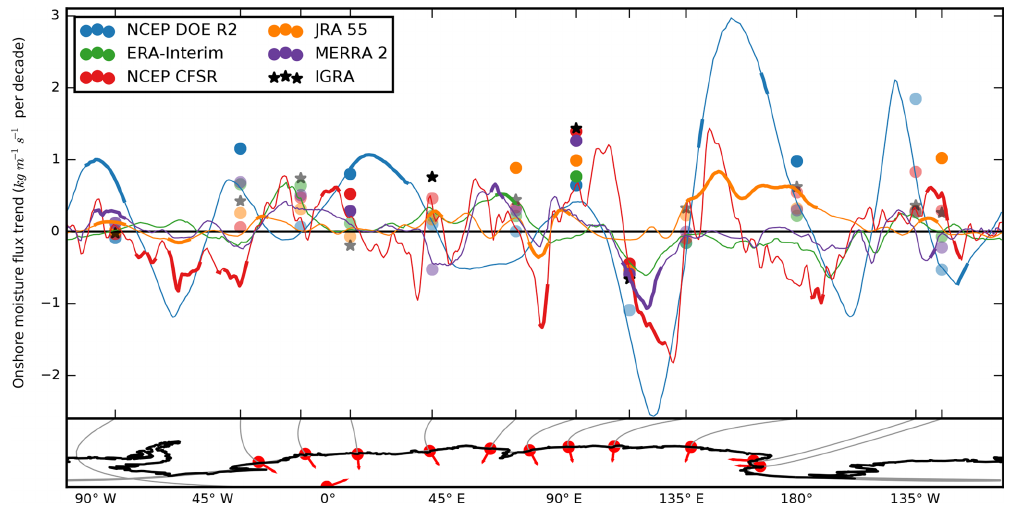
Figure 10. Linear trends of vertically integrated moisture transport into East Antarctica. The profiles are built from reanalyses over the 1980–2016 period interpolated along the domain boundary, whereas the dots are computed from reanalyses with the same temporal sampling as the observations. The stars correspond to trends computed from observations. The bold sections of the profiles and the solid dots and stars indicate statistically significant